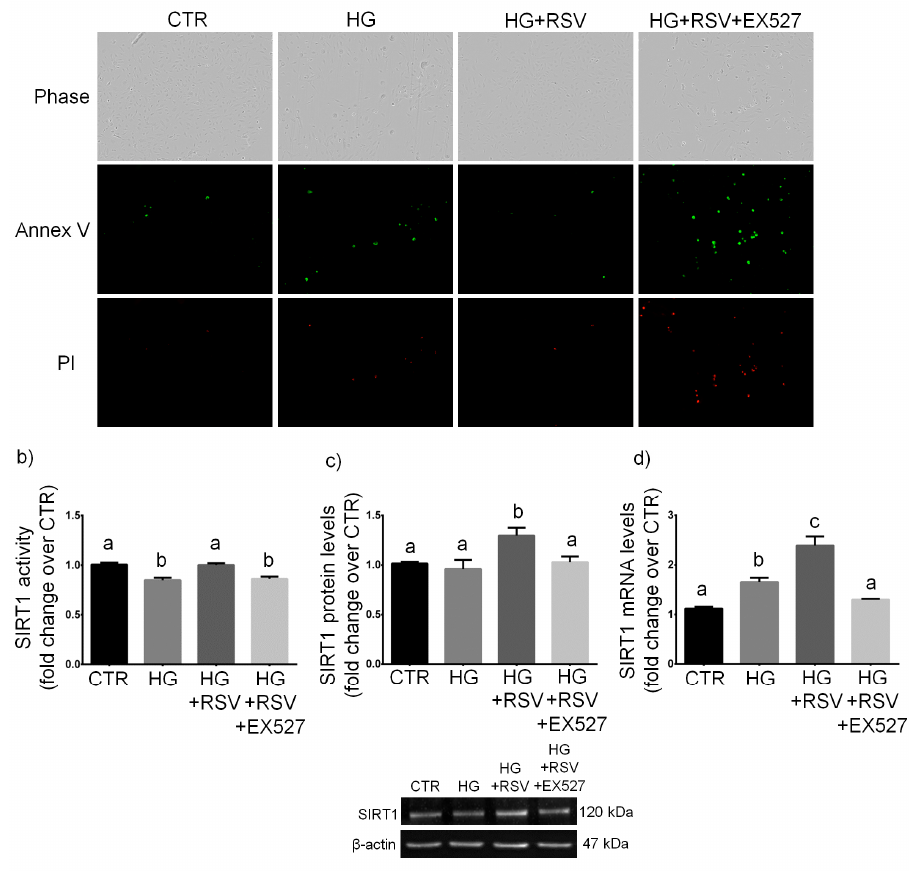
Figure 2. Effects of a 24-h treatment with either resveratrol alone (5 µM) or resveratrol + EX527 (5 µM and 13.4 µM, respectively) combination on viability, apoptosis, and necrosis ( a ), as well as on enzymatic activity ( b ), protein level ( c ), and transcript amount ( d ) of sirtuin 1 in high glucose-challenged HUVECs. Representative microphotographs (10 ×) and western blots are also shown (panels a and c, respectively). Data are expressed as means and S.E.M. Abbreviations: Annex V—annexin V; CTR—vehicle;